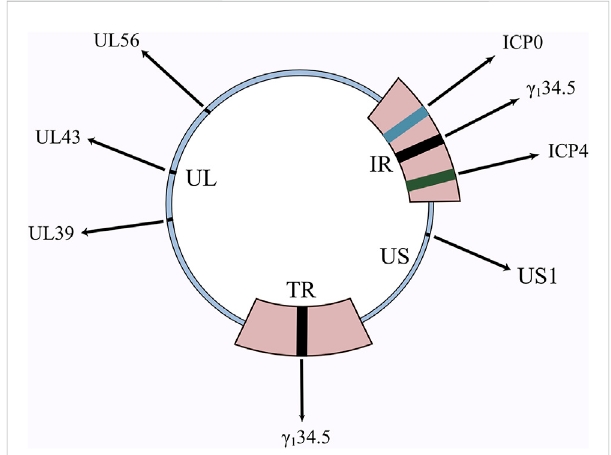
FIGURE 1 Schematicdiagram of HSV genome and important genes. γ 1 34.5, ICP0, ICP4, UL39, UL43, UL56 are all important genes in the HSV genome. The deletion of these genes, as well as the insertion of numerous other genes, has resulted in the birth of a diverse family of oncolytic